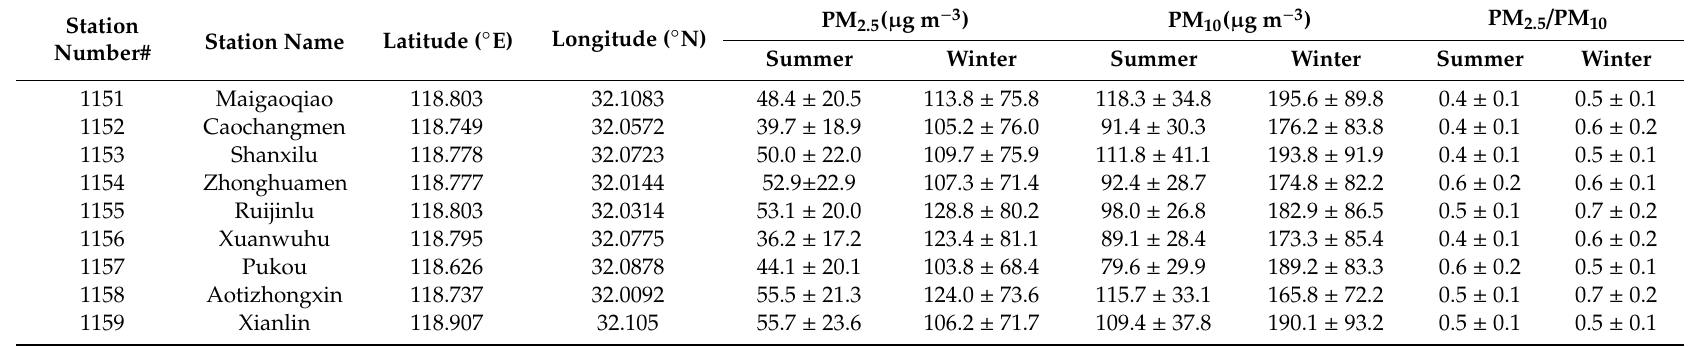
Table 1. Average concentrations of particulate matter (PM) 2.5 , PM 10 , and PM 2.5 / PM 10 ratio at the nine sites in Nanjing during the summer and winter pollution episodes in 2017, as defined in the